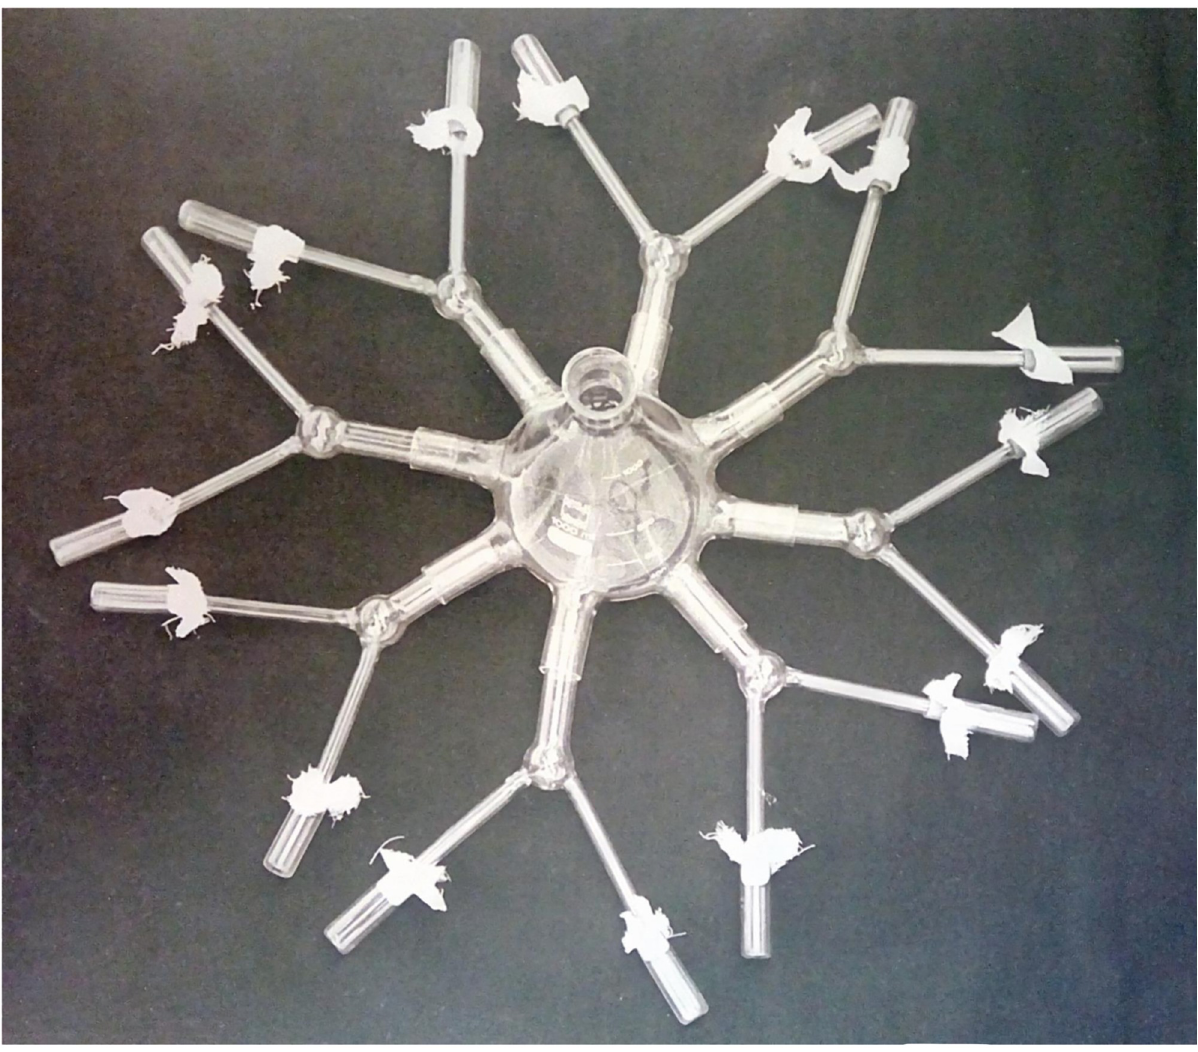
Fig 6. Apparatus used to study orientation of dispersal movements in adults of D . melanogaster and D . simulans . The flies were confronted with odors of the two species. The distal end of each Y-tube was connected to an empty cell impregnated with odors of the species.